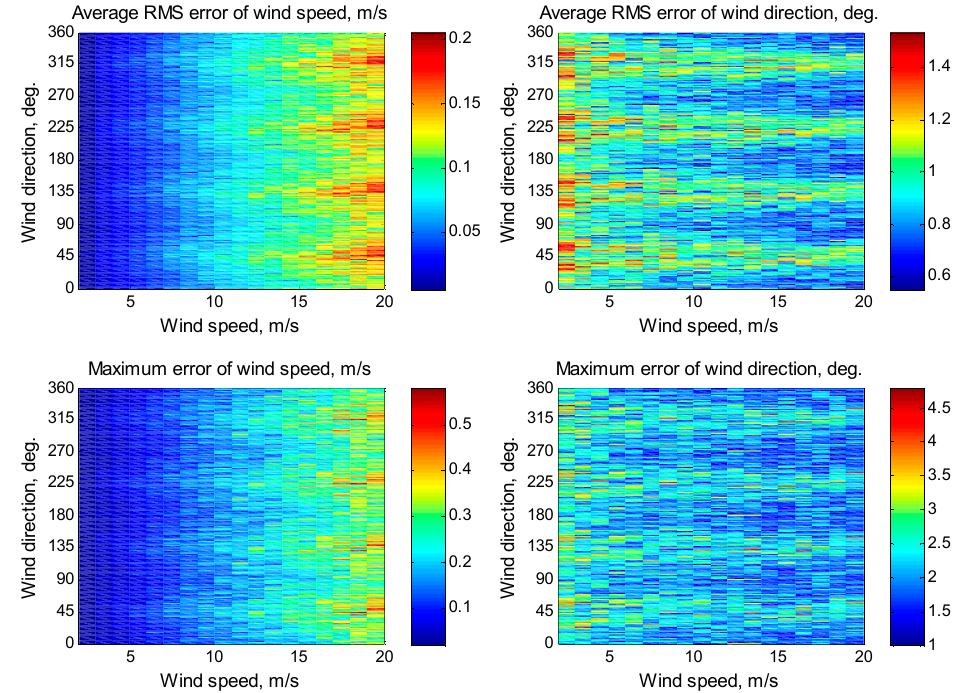
Figure 9. Simulation results for the mounting angle of a beam axis in the horizontal plane of 45° without instrumental noise at wind speeds of 2–20 m/s for the incidence angle of 45° with 1565 averaged NRCS samples for each azimuthal angle.